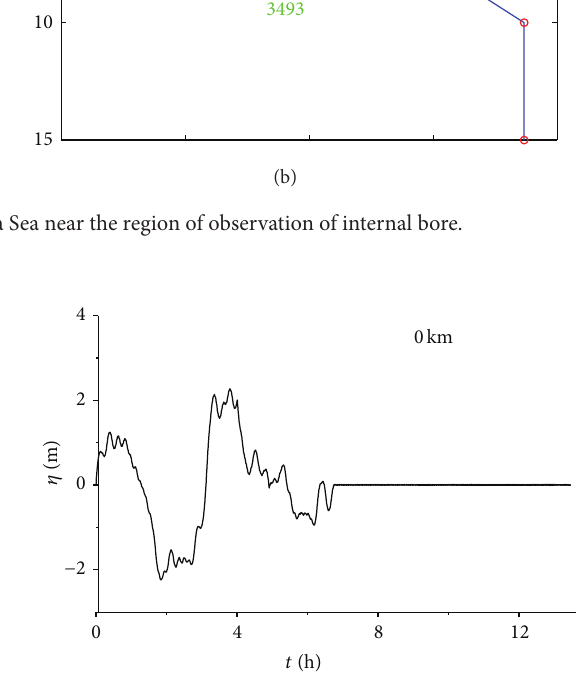
Figure 4: The shape of the initial condition (at 𝑥 = 0km) for